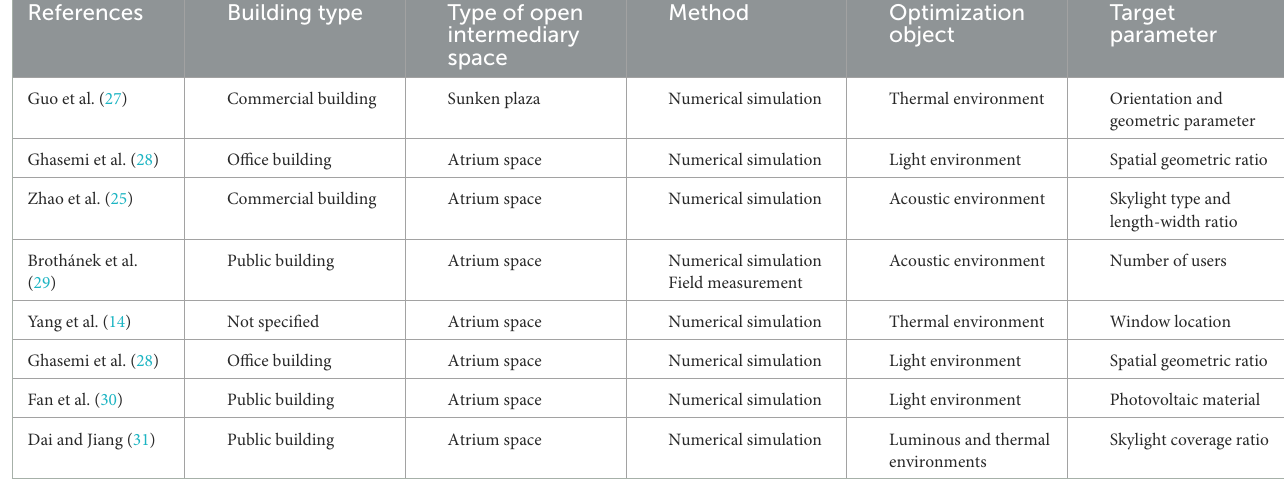
TABLE 1 A review of research methods, optimization goals, and parameter targets of previously studied open intermediary